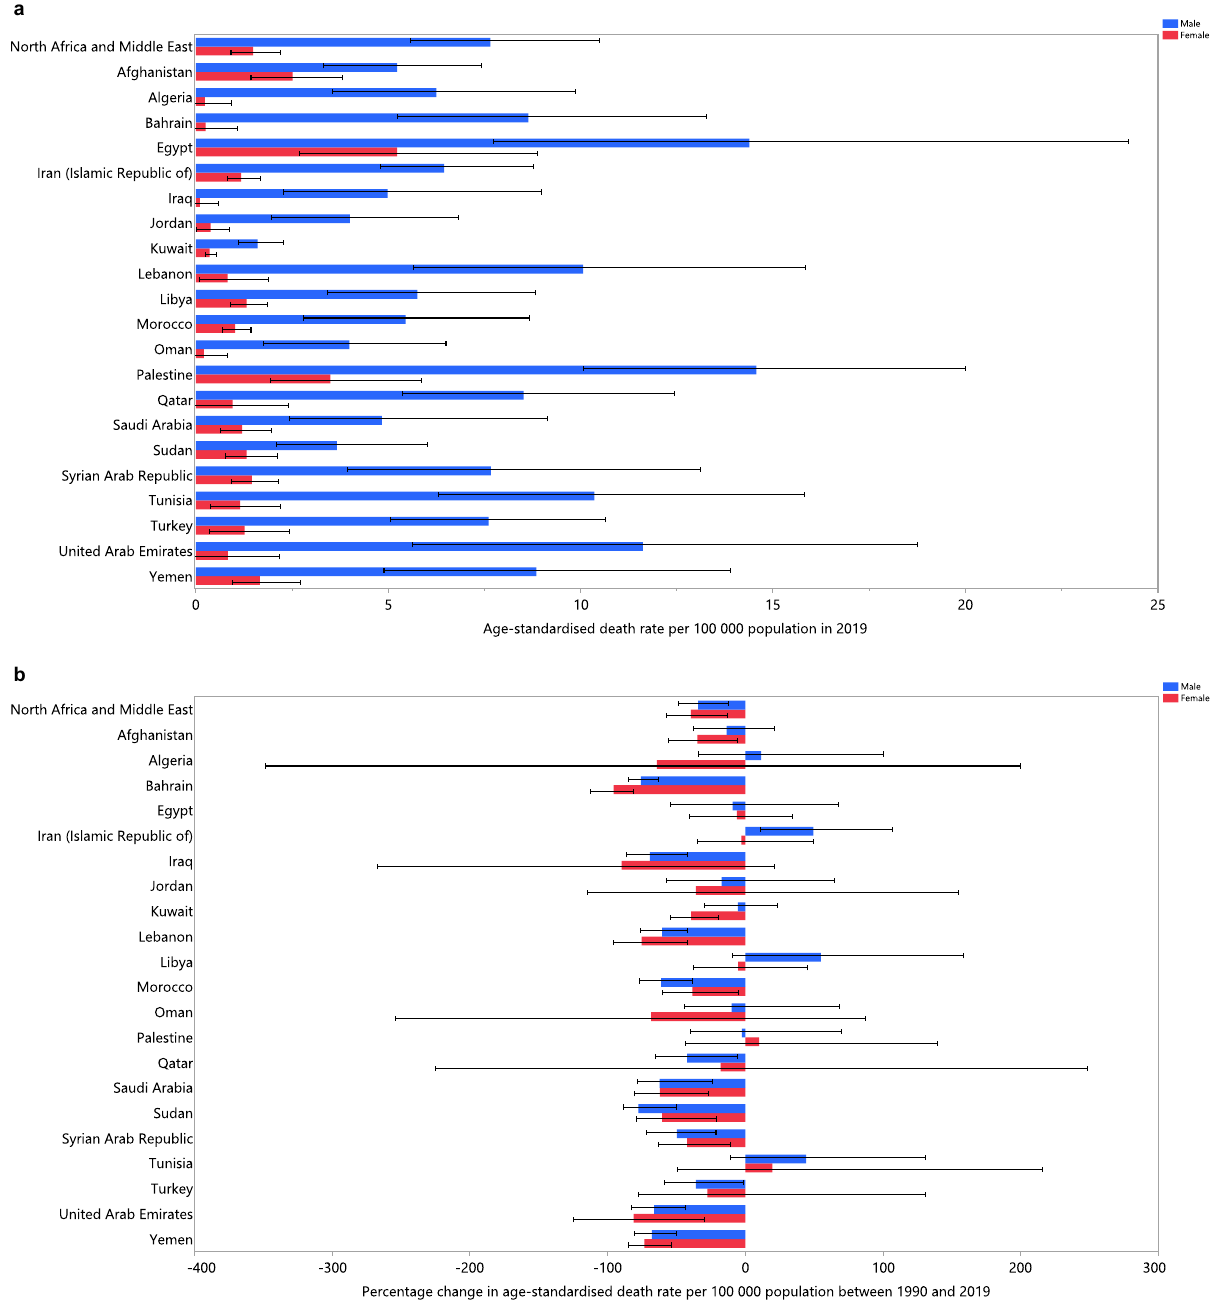
Figure 1. Age-standardised death rate (per 100,000 population) in 2019 ( a ) and percentage change in the age- standardised death rate from 1990 to 2019 ( b ) of disease and injuries attributable to alcohol consumption in the Middle East and North Africa region, by sex and country. (Generated from data available from http:// ghdx. healt hdata. org/ gbd- resul ts-